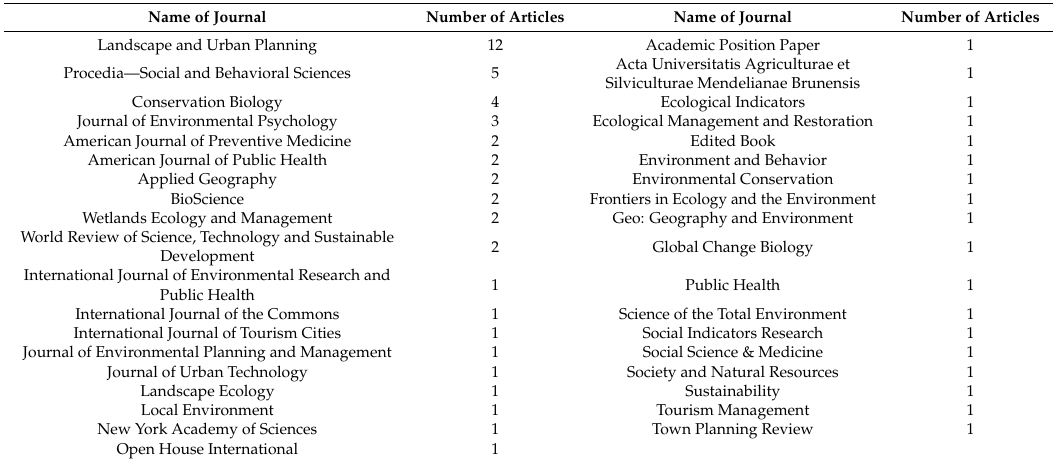
Table 8. Name of journals and frequency of reporting for research into the contribution that PGI spaces make to urban livability (n =